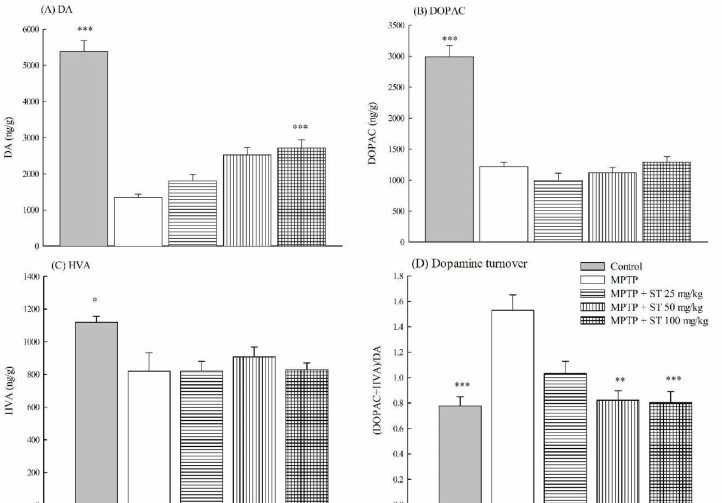
Figure 5. Effect of Sophora tomentosa extract (25 mg/kg, 50 mg/kg, and 100 mg/kg, po) on ( A ) dopamine (DA) levels, ( B ) 3,4-dihydroxyphenylacetic acid (DOPAC) levels, ( C ) homovanillic acid (HVA) levels, and ( D ) dopamine turnover in the striatum of an MPTP-induced PD mouse model. Data are expressed as mean ± SEM ( n = 5). * p < 0.05, ** p < 0.01, *** p < 0.001, compared